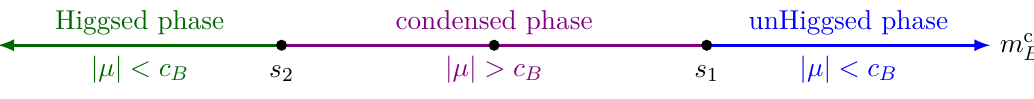
Figure 2 . Phase diagram of critical boson theory as a function of m cri at fixed µ . At the points B (cid:0) 2 −| λ (cid:1) s 1 = | µ | , s 2 = −| µ | the theory undergoes a second order phase transition. The point inside B | | λ B | (cid:0) 1 −| λ (cid:1) the condensed phase corresponds to m cri = −| µ | and denotes a change in description from B | B | λ B | that a phase of condensed scalars to one of phase of condensed W -bosons though the condensed phase is itself